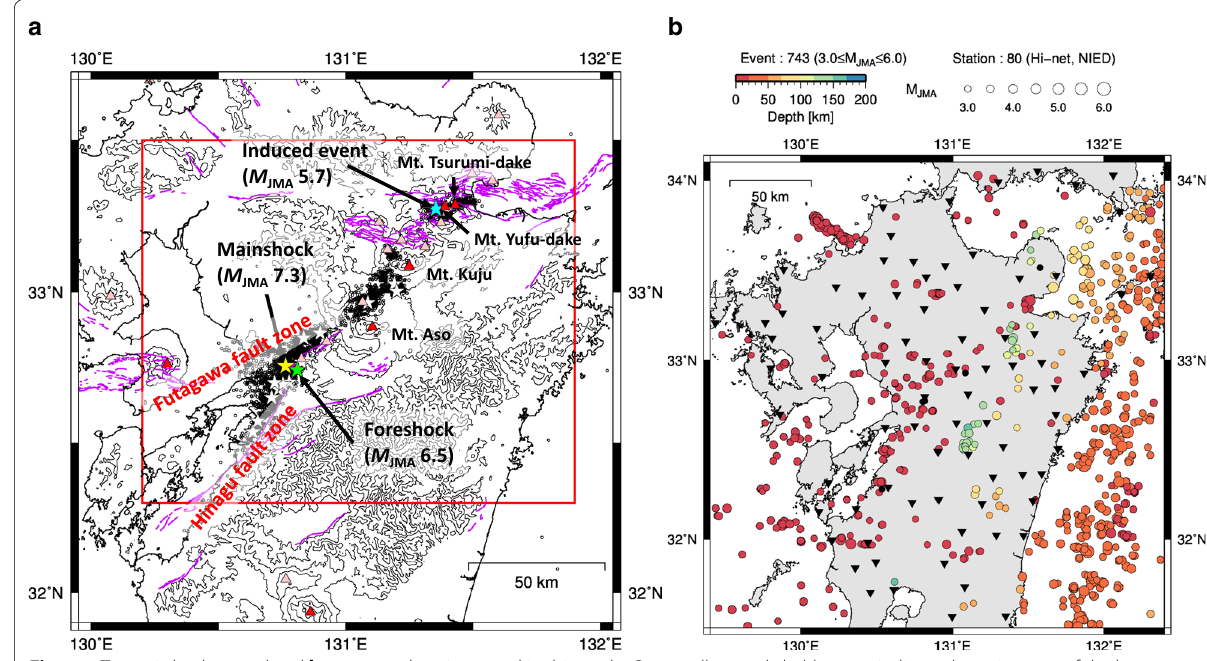
Fig. 1 a Tectonic background and b events and stations used in this study. Green , yellow , and sky blue stars indicate the epicenters of the largest foreshock ( M JMA 6.5), the mainshock ( M JMA 7.3), and the induced event ( M JMA 5.7), respectively. White stars denote the epicenters of events larger than M JMA 5.0 for one month following the foreshock. Black circles indicate the epicenters of events with 2.0 M JMA < 5.0 occurring for one month follow- ≤ ing the foreshock. Active and quaternary volcanoes are shown as red and peach triangles , respectively. Purple lines denote active faults (Nakata and Imaizumi 2002). Black lines are contours of altitude with intervals of 300 m. The red square corresponds to the area shown in Fig. 2. Colored circles and inverse triangles show the events and stations used in this study. The color and size of each circle indicate the depth and the magnitude of the